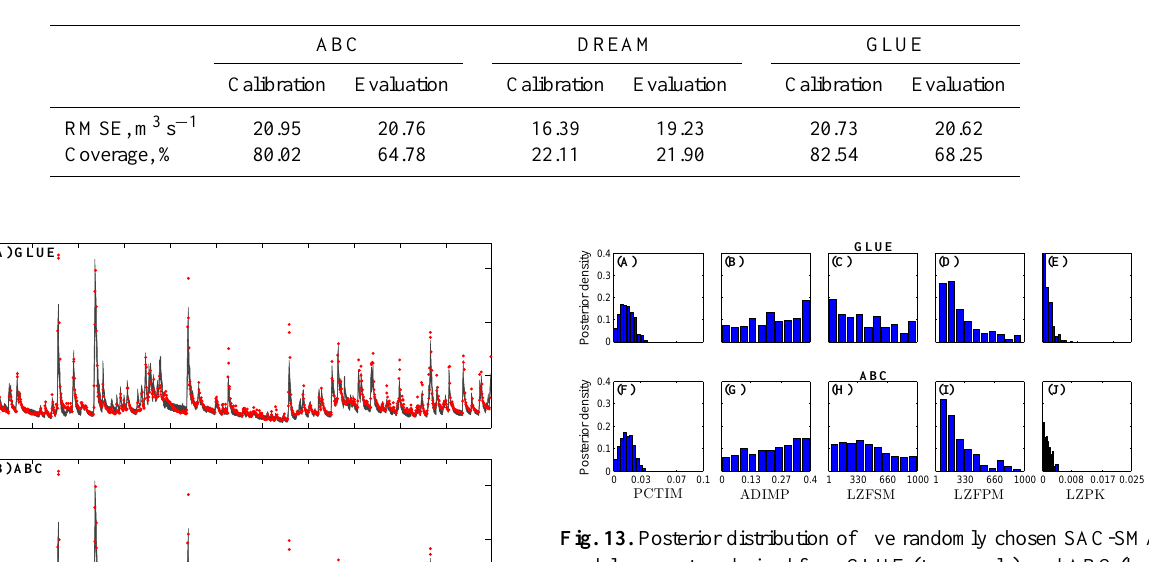
Fig. 13. Posterior distribution of five randomly chosen SAC-SMA model parameters derived from GLUE (top panels), and ABC (bot- tom panels) using historical streamflow data from the Leaf River watershed in